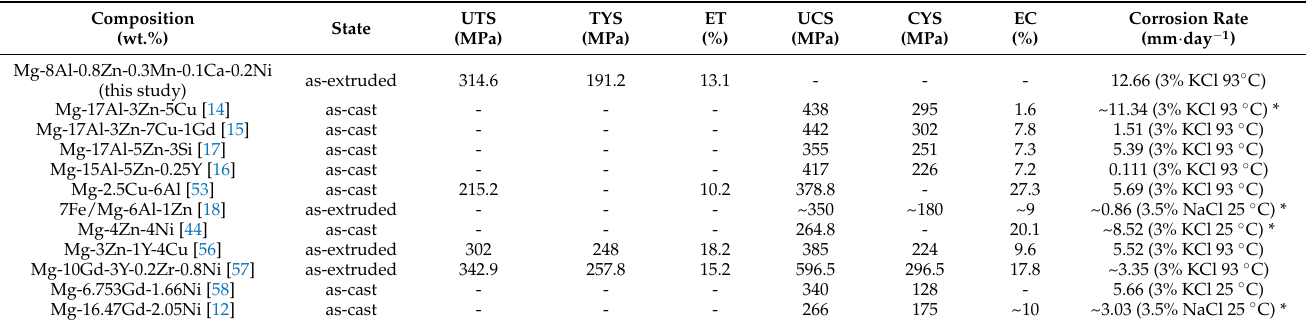
Table 4. The comparison of mechanical and corrosion properties of the Mg-Al-Zn-Mn-Ca-Ni alloy developed by our group and other reported typical dissoluble magnesium